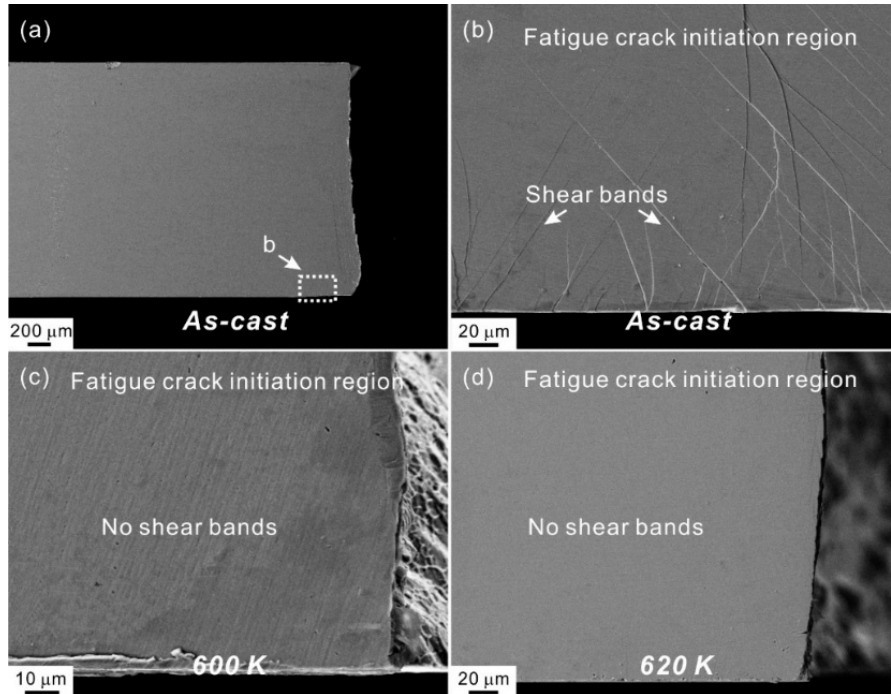
Figure 14. SEM observations on the tensile-side surface near the fatigue crack initiation regions of ( a,b ) as-cast, ( c ) 600 K (AS2) and ( d ) 620 K (AS1) annealed samples after fatigue fracture, respectively [53].